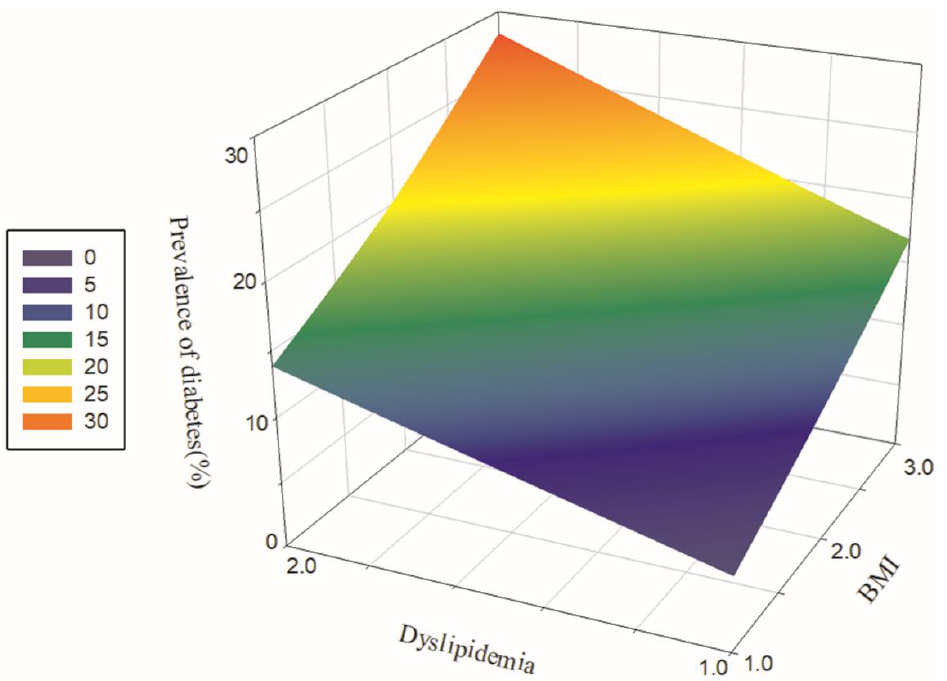
Figure 2. Relationship amongst dyslipidaemia, BMI and the prevalence of diabetes. Note: BMI: 1 =